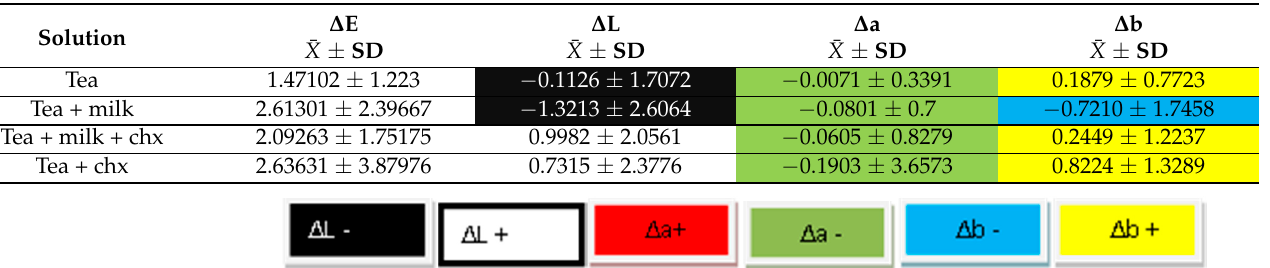
Table 3. Mean and standard deviation ∆ E, ∆ L, ∆ a, and ∆ b values for solutions containing tea, tea + milk, tea + milk + chx, or tea + chx.